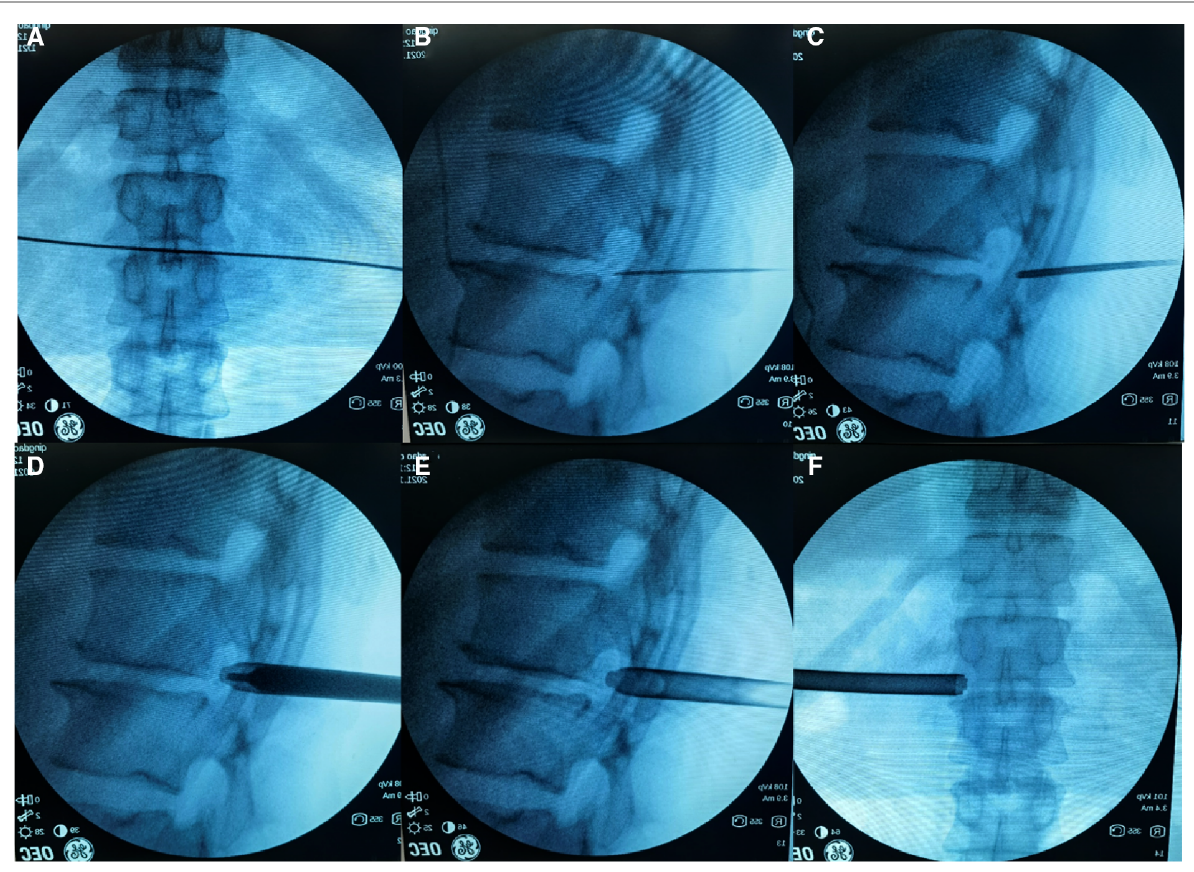
FIGURE 1 The procedure of establishing the working cannula with C-arm fl uoroscopy assistance. ( A ) The location of segment to be operated. ( B ) The 18 G puncture needle inserted onto the lateral side of superior articular process. ( C ) The primary guide rod introduced through the guide wire. ( D ) The U -shaped working cannula introduced through the second guide rod. ( E,F ) The fi nal location of the U -shaped working cannula under the anteroposterior and lateral view of C-arm fl